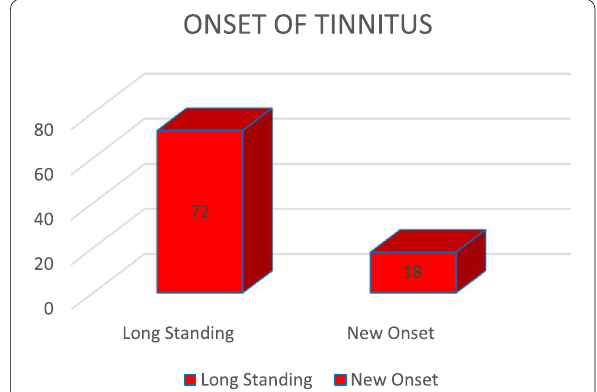
Fig. 1 Distribution of patients according to onset of tinnitus